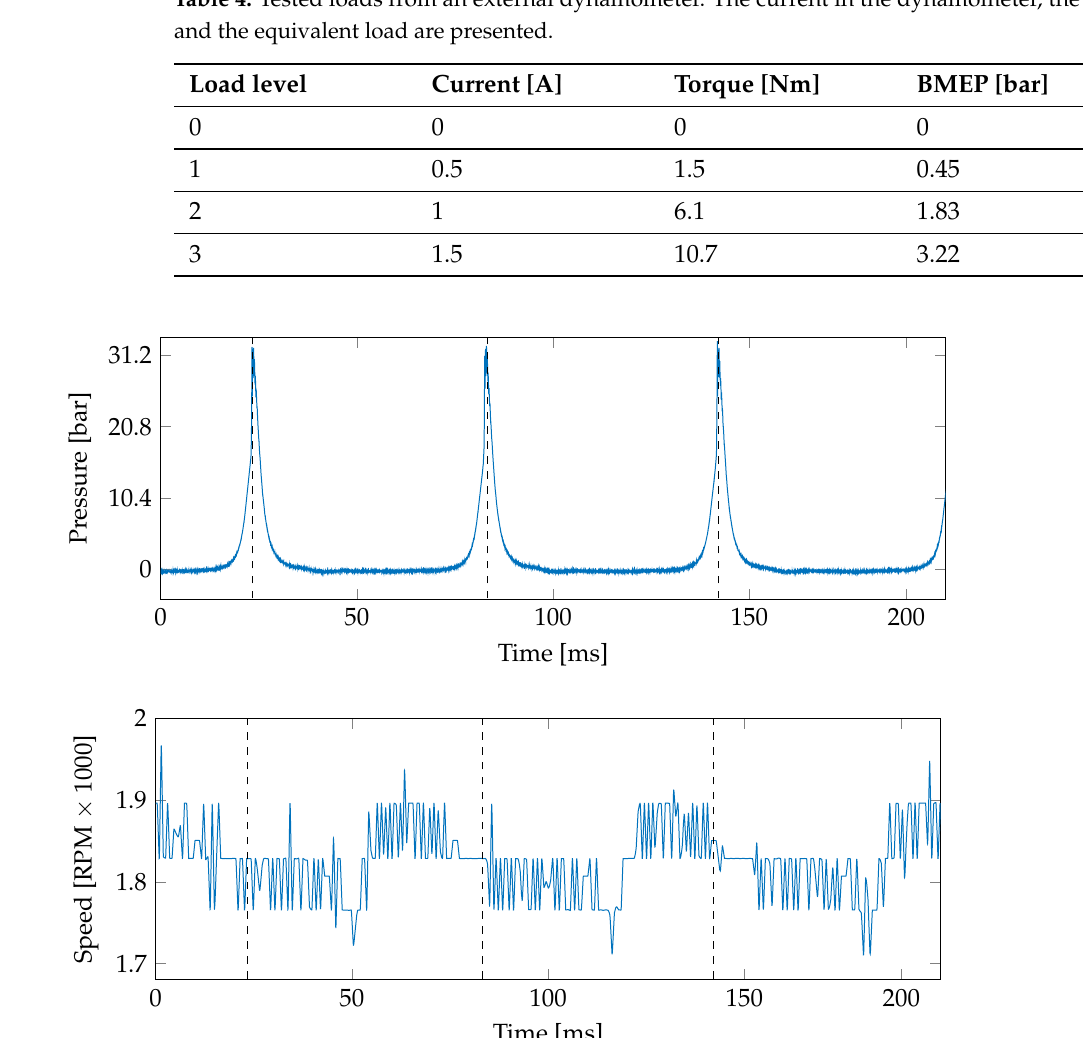
Figure 4. Examples of the pressure and angular velocity signals. The engine velocity and load are fixed to 1800 RPM and 3.22 BMEP, respectively. Please note that the velocity variations around 1800 RPM allow predicting the pressure signal based on our TDNN